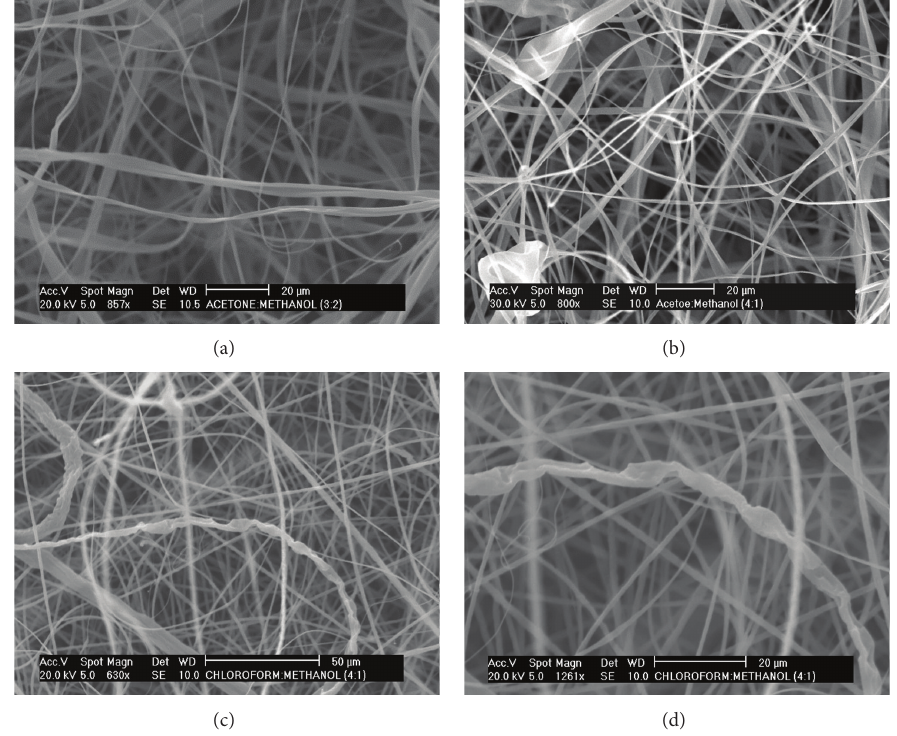
Figure 3: SEM micrographs showing the effect of binary solvent systems on web structure and CA electrospun fibre morphology. Mag 630x– 1260x-electrospinning solvents: (a) acetone: methanol (3:2); (b) acetone :methanol (4:1); (c) chloroform:methanol (4: 1); (d) ribbon-like structure in an electrospun CA fibre produced from the Chloroform:methanol (4:1) solvent.